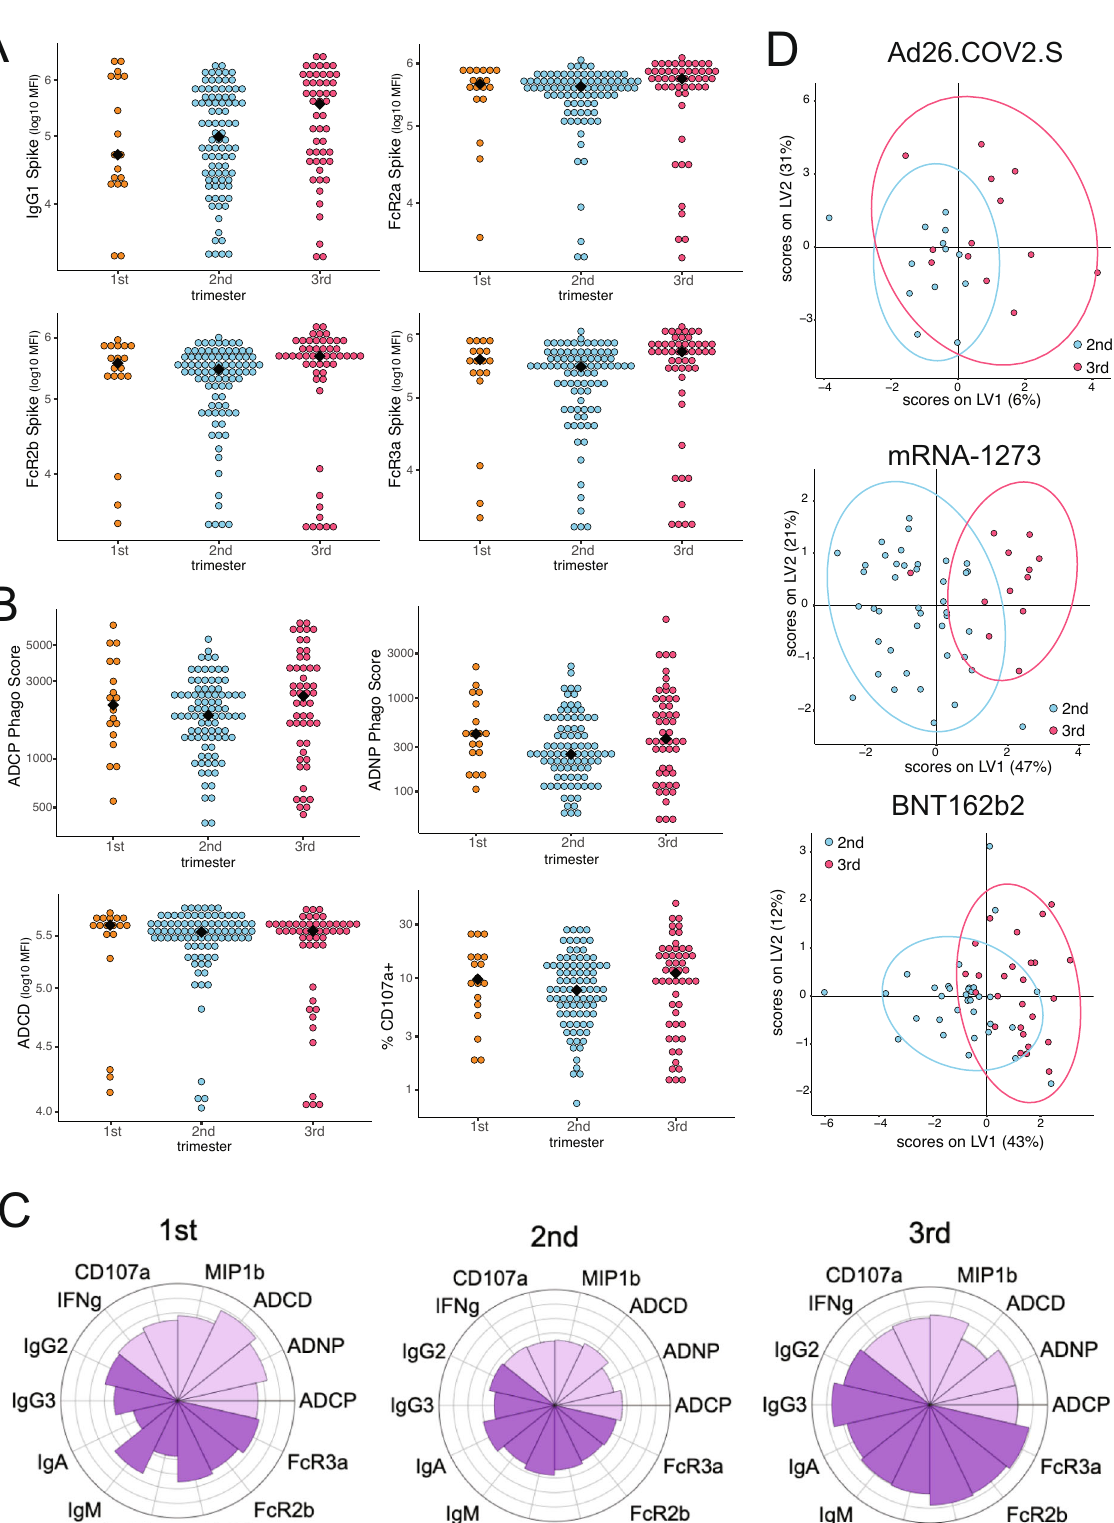
overlap, the Ad26.COV2.S cord blood response separated from the two other vaccine responses (Fig. 3D). Moreover, all LASSO- selected features were enriched in the cord blood of women who had received mRNA-1273 or BNT162b2 compared to Ad26.COV2.S (Fig. 3E). These data demonstrate strong simila- rities between maternal and cord blood antibody titers